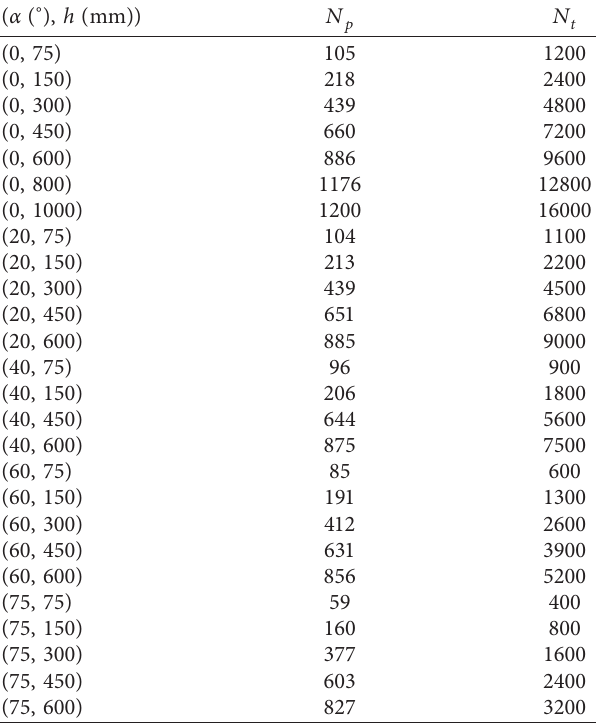
Table 3: Simulations performed in the case without periodic BC for various hopper angles α and particle bed heights h .